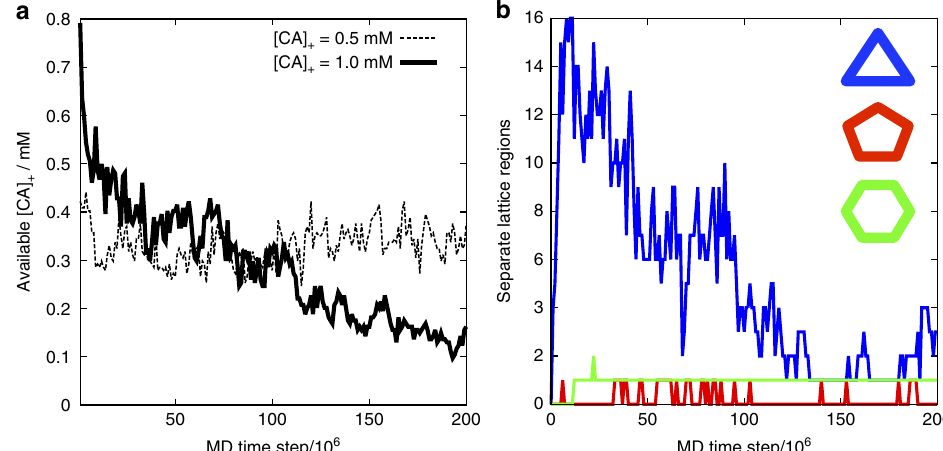
Figure 5 | Example CG simulation data under fixed molecular crowding. ( a ) ‘Available’ assembly-competent CA in solution for initial [CA] þ ¼ 0.5mM (resulting in no nucleation and growth of mature lattice) and initial [CA] þ ¼ 1.0mM (producing nucleation and growth of a single-lattice region, see the